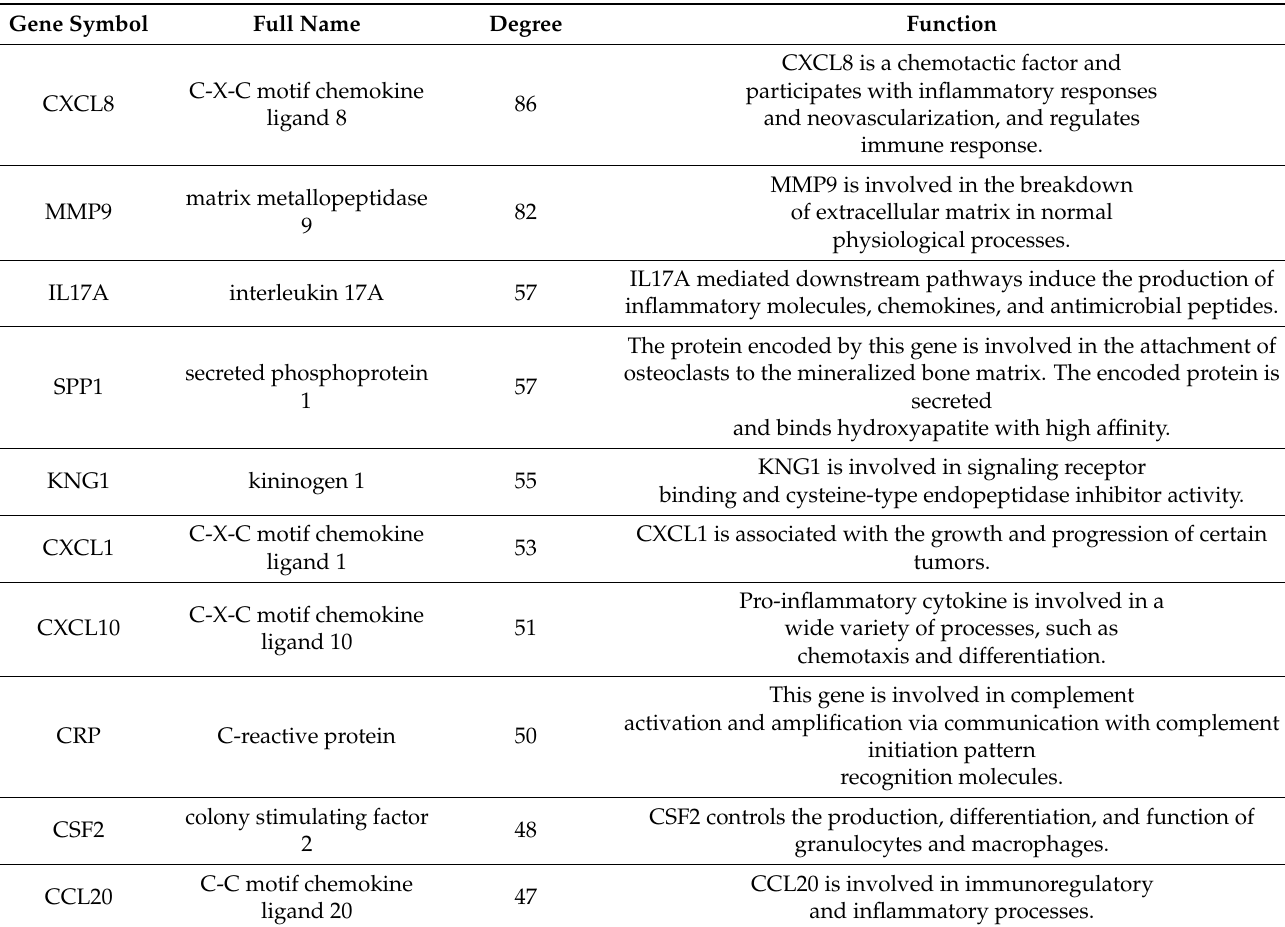
Table 2. Functional roles of 10 hub genes.